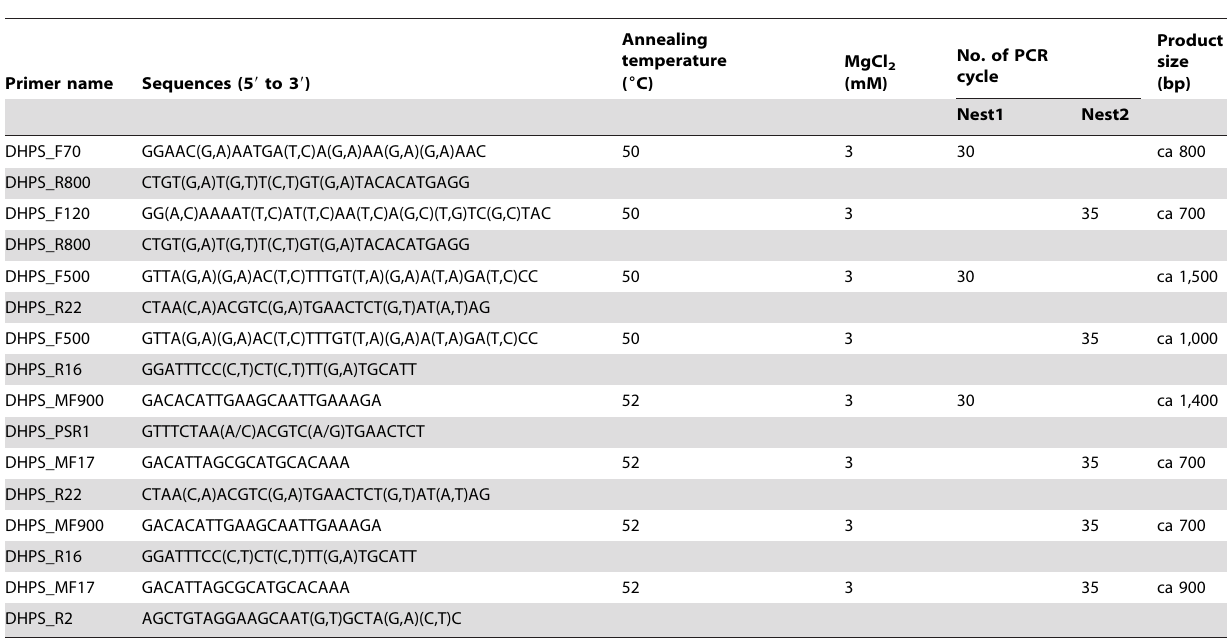
Table 1. Primer sequences and PCR condition for isolation of pppk-dhps gene from P. malariae and P. brasilianum .